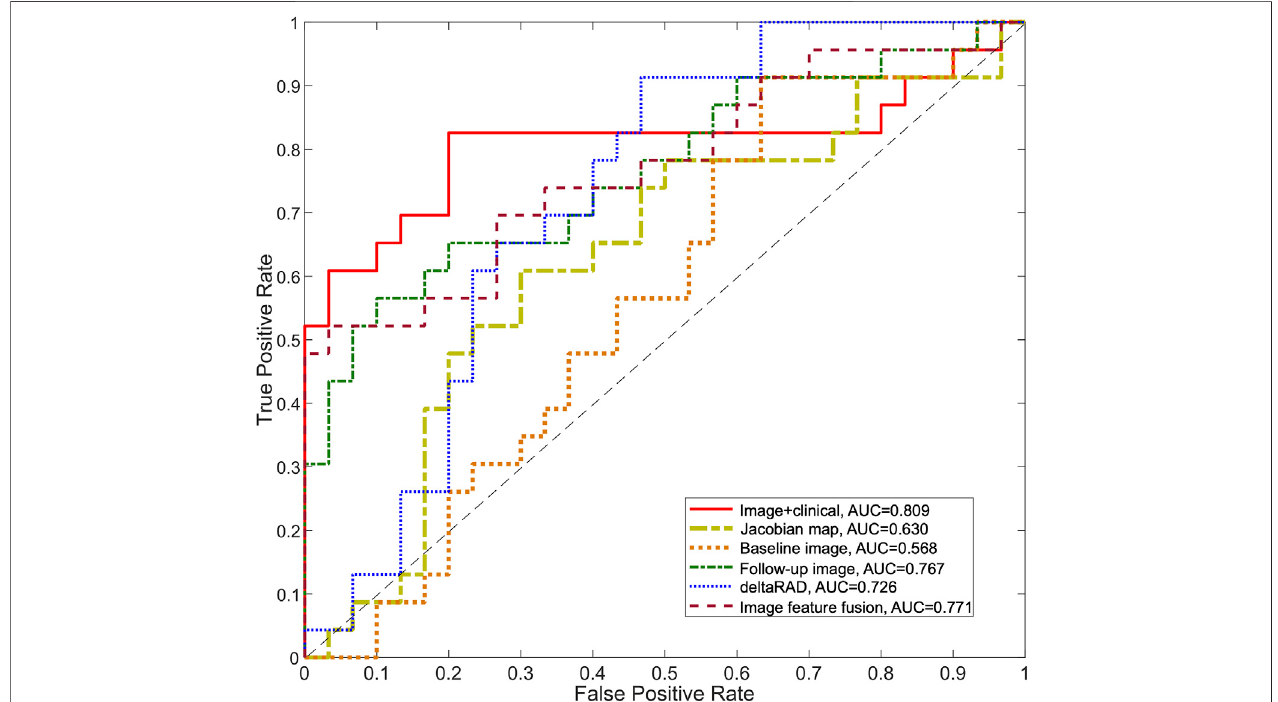
FIGURE 7| ROC curves for thepredictive models using longitudinal images. The ROC curves for the predictive model using deltaRAD and radiomics derived from pre- and post-treatment images, the Jacobian map and the fused imaging features are shown. The ROC curve of the predictive model combining imaging features and molecular subtype information is also